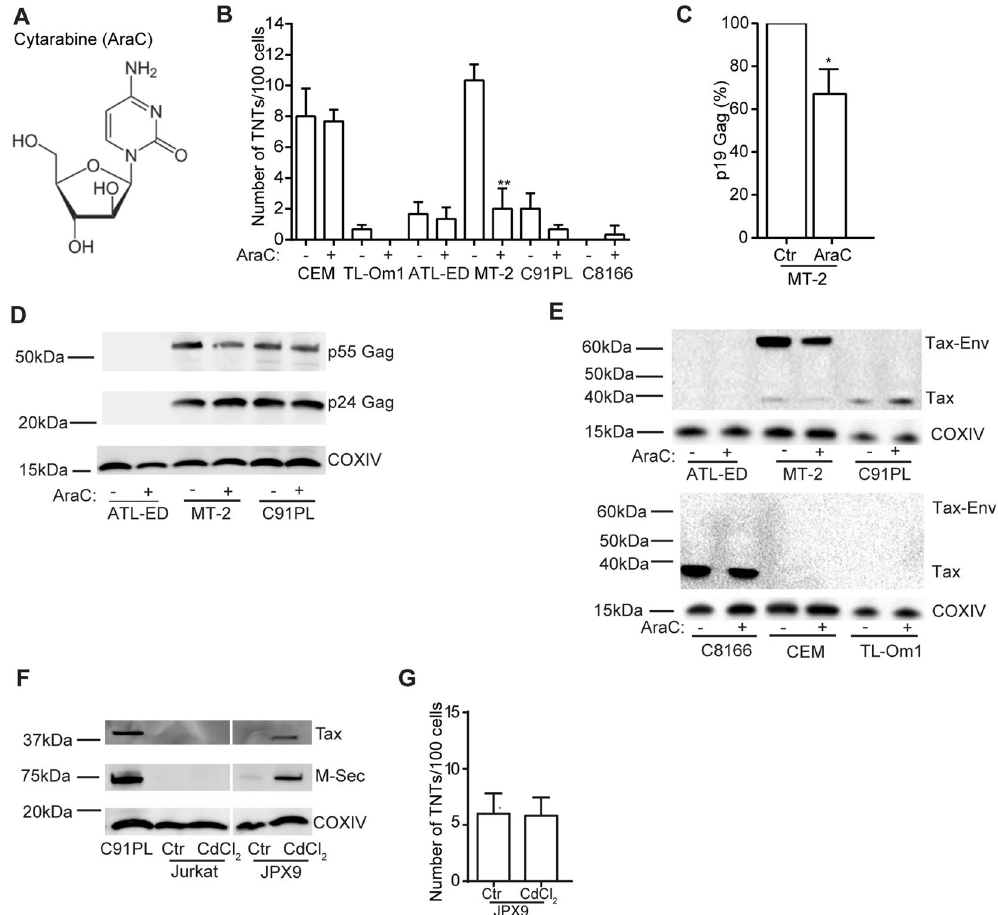
Figure 5. Cytarabine treatment reduces TNT numbers in HTLV-1 expressing cells. ( A ) Molecular structure of cytarabine (AraC). ( B ) Quantification of TNTs in cell lines before and after cytarabine (AraC) treatment (1 µ M, 24 h). ( C ) Quantification of p19 Gag (pg/ml) by the HTLV-1 antigen capturing ELISA kit in MT-2 supernatant before and after treatment with AraC (1 µ M, 24 h). ( D ) Immunoblotting of ATL-ED, MT-2 and C91PL cells before and after treatment with AraC (1 µ M, 24 h) with antibodies against p24/p55 Gag and COXIV (loading control). ( E ) Immunoblotting of C8166, CEM, TL-Om1, ATL-ED, MT-2 and C91PL cells before and after treatment with AraC (1 µ M, 24 h) with antibodies against Tax and COXIV (loading control). ( F ) Immunoblotting of Jurkat and JPX9 (Tax wt) cells, before and after CdCl 2 treatment; antibodies against Tax, M-Sec and COXIV (loading control). Lysates of C91PL cells: positive control of Tax and M-Sec expression. Results are representative of three independent experiments. ( G ) Quantification of TNTs in JPX9 cells before and after treatment with CdCl 2 . All error bars indicate the mean ± standard deviation. For TNT quantifications; all data are presented as three independent experiments in duplicates, p19 Gag quantifications; all data are presented in percentage as three independent experiments. The immunoblots are representatives of three independent experiments. Unpaired t-test was performed to evaluate statistic significance. F-test was performed for individual variation. GraphPad Prism (Version 6.03) was used ( * p < 0.05, ** p < 0.01). Scale bars: 10 µ m. Full-length immunoblots are presented in Supplementary Fig.